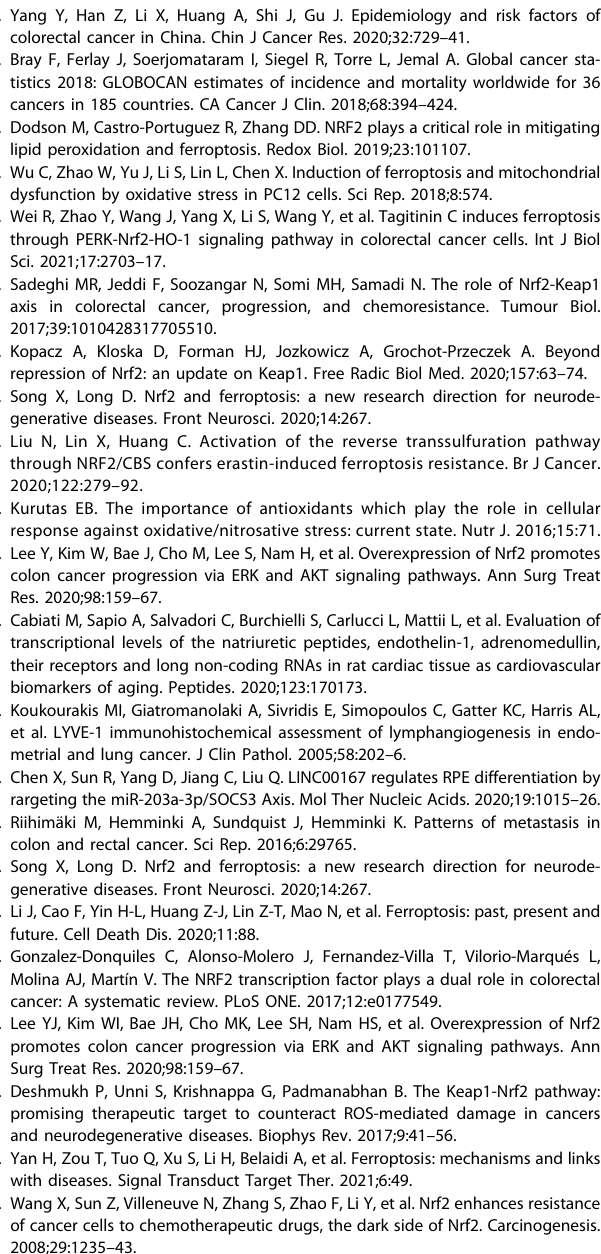
Fig. 6 Ibrutinib sensitizes CRC tumors to RSL3 or Erastin-induced ferroptosis in vivo. The HT-29 cells were implanted into the subcutaneous space of the nude mice. After seven days, these mice were treated with RSL3, Erastin, Ibrutinib, RSL3 and Ibrutinib, or Erastin and Ibrutinib. A The images and B its quanti fi cation results of CRC tumors from different groups. C The expressions of Nrf2, GPX4, SOD1, and CAT in mice that were treated with RSL3, Erastin, Ibrutinib, RSL3 and Ibrutinib, or Erastin and Ibrutinib. D – F The CRC suspension that derived from CRC tumors from the patients was intravenously injected through the tail vein into mice and after seven days, the mice were RSL3, Erastin, Ibrutinib, RSL3 and Ibrutinib, or Erastin and Ibrutinib. The images of lung, the quanti fi cation results of lung metastasis numbers calculated from lung sections and the H&E staining of lung sections from different groups. Scale bar = 100 μ m. G The representative immunohistochemistry images of lung sections from different groups indicate the Nrf2, GPX4, SOD1, and CAT expressions. Scale bar = 100 μ m. All experiments were carried out at least three times, n = 3, * P < 0.05, ** P < 0.01 and *** P <